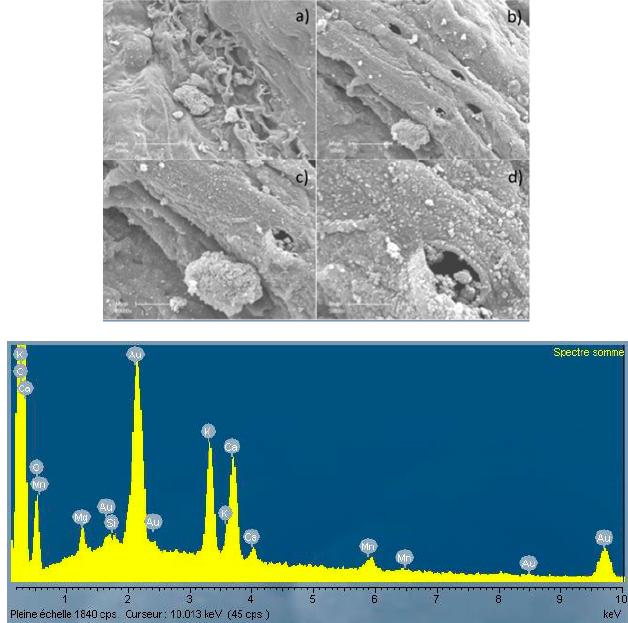
Figure 5. SEM photographs and X-ray fluorescence analysis of the surface of the biochar produced after pyrolysis of wood particles at 1200 °C and different enlargements ( a ) ×5000; ( b ) ×10,000; ( c ) ×20,000; and ( d ) ×50,000.